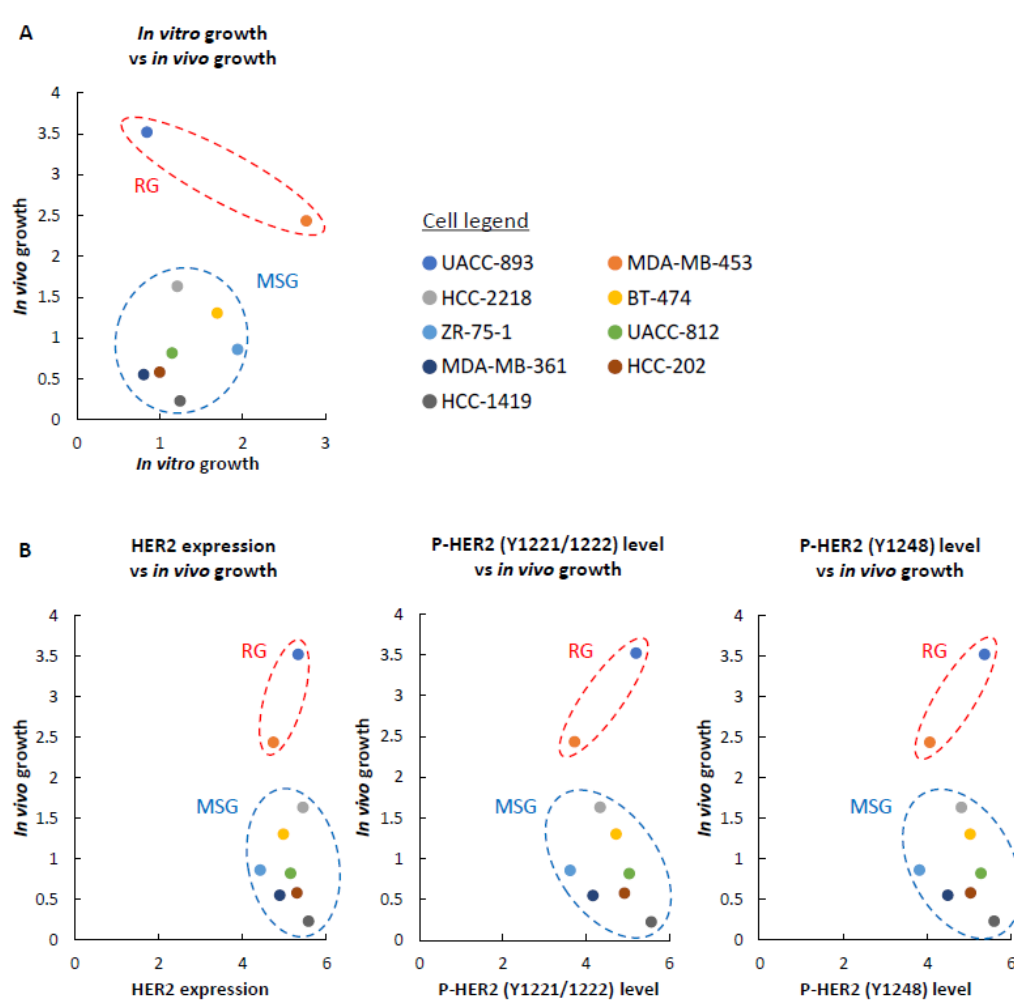
Figure 1. Intracranial injection of nine HER2-positive breast cancer cell lines. UACC-893-luc2, MDA-MB-453- luc2, HCC-2218-luc2, BT-474-luc2, ZR-75-1-luc2, UACC-812-luc2, MDA-MB-361-luc2, HCC-202-luc2, and HCC-1419-luc2 cells were intracranially injected into NOD-SCID mice (HCC-2218-luc2 and HCC-1419-luc2, n = 4; others, n = 3). Cell proliferation was quantified by measuring bioluminescence every seven days and plotted in the form of a growth ratio. Each line shows the corresponding mouse. Left: Bioluminescence on day 0. Right: Bioluminescence on day 28. ( A ) Cell lines in the rapid growth group (RG). ( B ) Cell lines in the moderate to slow growth group (MSG).